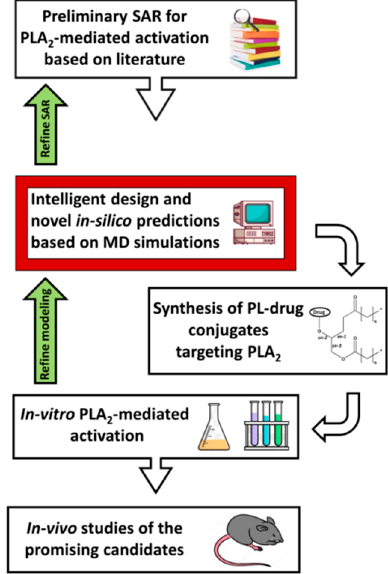
Figure 7. Flow ‐ chart of our proposed PL ‐ drug conjugates development process. SAR—structure ‐ activity relationship; MD—molecular dynamics; PL—phospholipid; PLA 2 —phospholipase A 2 .